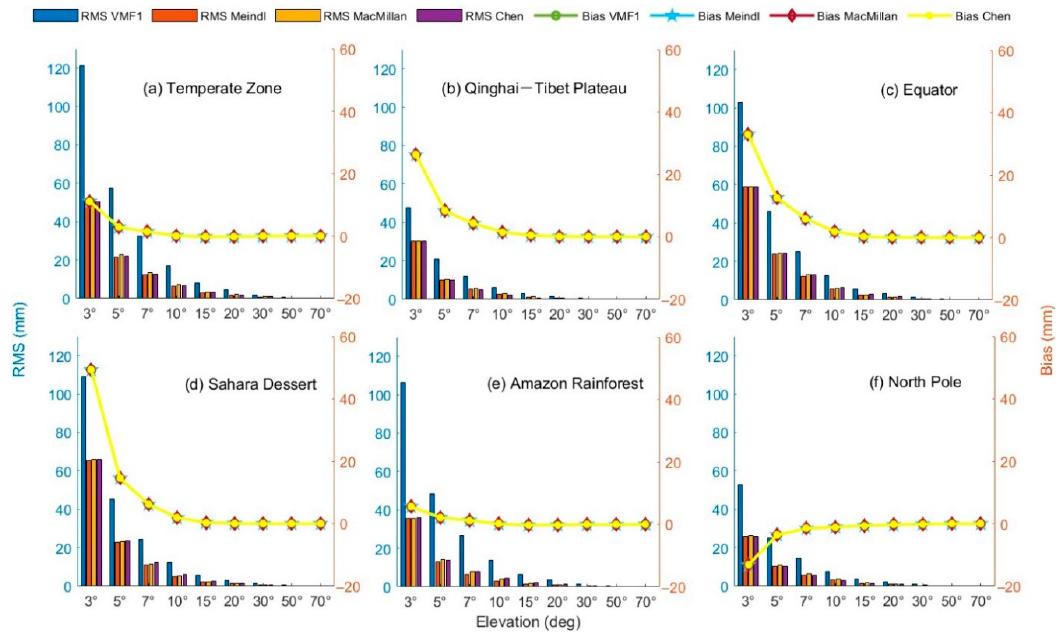
Figure 5. The RMSs and biases of VMF1 and VMF1 with three gradient models for the six regions at the nine elevations (70°, 50°, 30°, 20°, 15°, 10°, 7°, 5°, 3°) in four seasons: ( a ) Temperate Zone ( b ) Qinghai—Tibet Plateau ( c ) Equator ( d ) Sahara Dessert ( e ) Amazon Rainforest ( f ) North Pole. The blue bar and yellow line are the RMS and bias, respectively, of the STD determined with VMF1 without the gradient model. All three gradient models studied show very similar performances in the six selected regions.